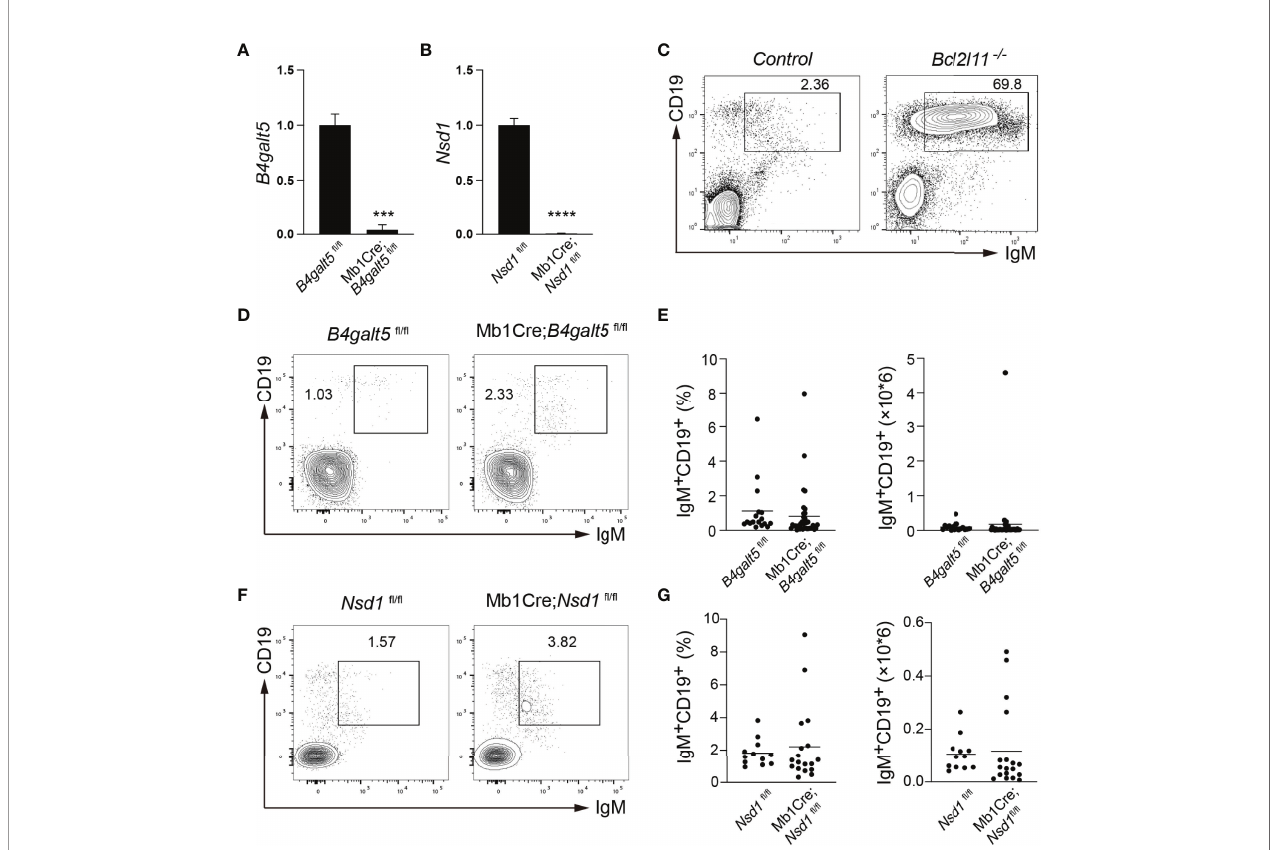
FIGURE 5 | In vivo validation in IgM b -macroself mice with bone marrow cells from conditional knockout mice. (A, B) Expression levels of B4galt5 (A) and Nsd1 (B) in splenic B cells from Mb1Cre; B4galt5 fl / fl and Mb1Cre; Nsd1 fl / fl mice analyzed by qRT-PCR. Bar graph shows mean + SD. Data are representative of 2 independent experiments using technical triplicates. (C) Representative fl ow cytometry plots analyzing splenocytes from IgM b -macroself mice reconstituted with bone marrow cells from C57BL/6J mice and Bcl2l11 -/- mice at terminal analysis. Numbers adjacent to outlined areas indicate percentage of IgM + CD19 + B cells among splenocytes. (D) Representative fl ow cytometry plots analyzing splenocytes from IgM b -macroself mice reconstituted with bone marrow cells from B4galt5 fl / fl and Mb1Cre; B4galt5 fl / fl mice at terminal analysis. Numbers adjacent to outlined areas indicate percentage of IgM + CD19 + B cells among splenocytes. (E) Graphs summarizing percentages and numbers of IgM + CD19 + splenic B cells of mice analyzed in (D) . (F) Representative fl ow cytometry analysis of splenocytes from IgM b - macroself mice reconstituted with bone marrow cells from Nsd1 fl / fl and Mb1Cre; Nsd fl / fl mice at terminal analysis, with numbers adjacent to outlined areas indicating percentage of IgM + CD19 + B cells among splenocytes. (G) Graphs summarizing percentages and numbers of IgM + CD19 + splenic B cells of mice analyzed in (D) . Data in (E) and (G) are pooled from 3 and 2 independent experiments, respectively with n=17 for B4galt5 fl / fl , n=41 for Mb1Cre; B4galt5 fl / fl , n=12 for Nsd1 fl / fl ,